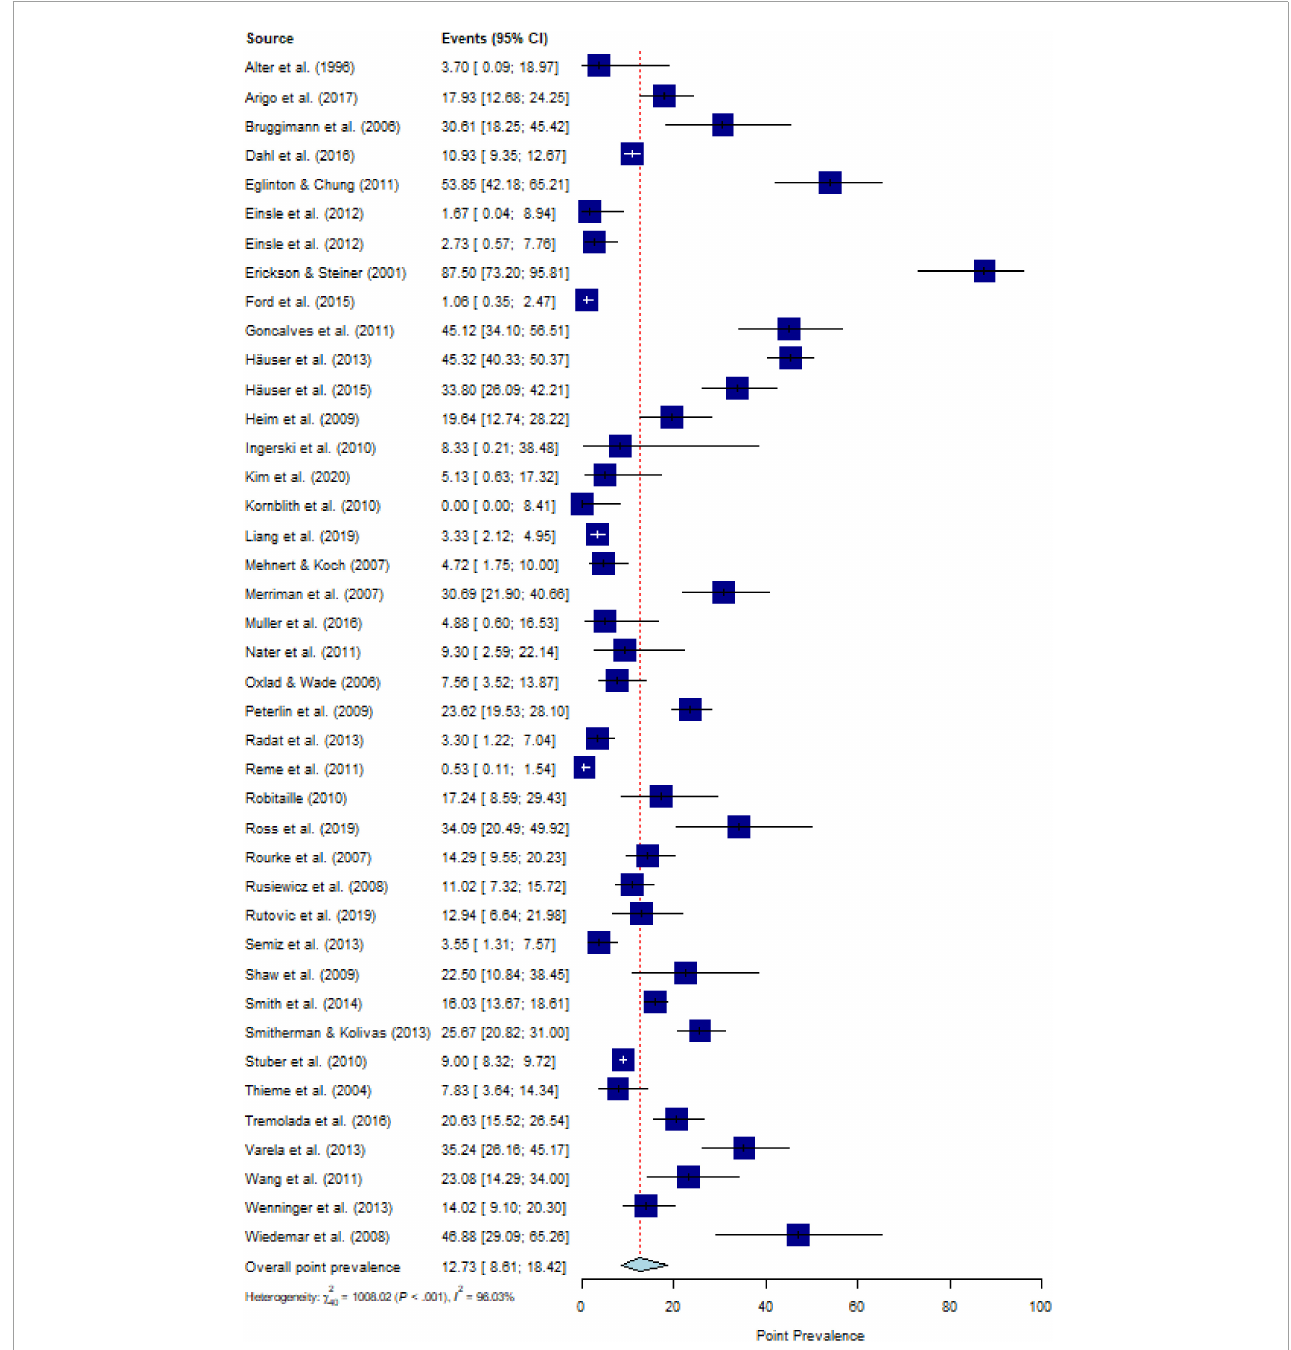
FIGURE2 Forest plot of point prevalence of post-traumatic stress disorder (PTSD) in people with chronic somatic diseases